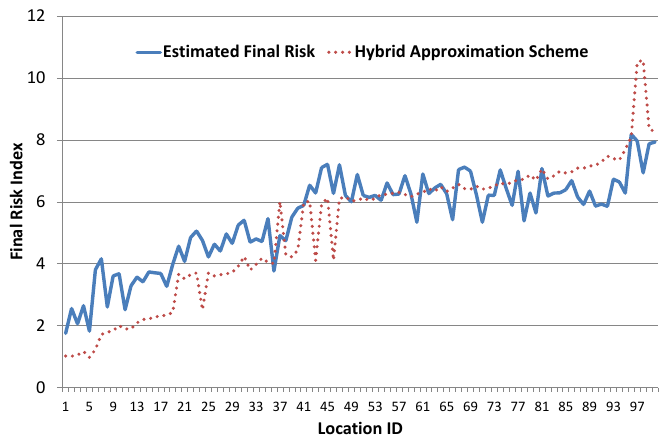
Figure 12. Final risk index results using hybrid approach.